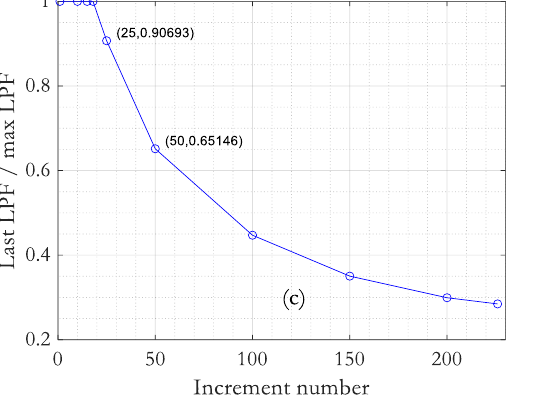
Figure 10. Combined results for mesh 02 including: ( a ) convergence requirements and elapsed simulation time; ( b ) horizontal load for a given increment number; and ( c ) ratio of the LPF of the current increment and the highest LPF simulation value observed in the previous increments.